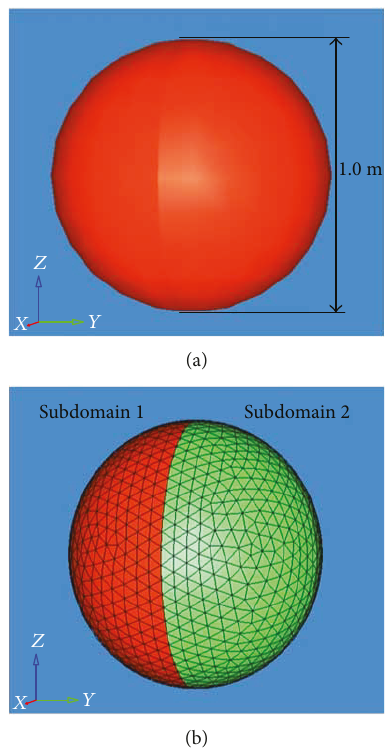
Figure 8: (a) The model of a dielectric sphere. (b) Subdomain partitions of the dielectric sphere.